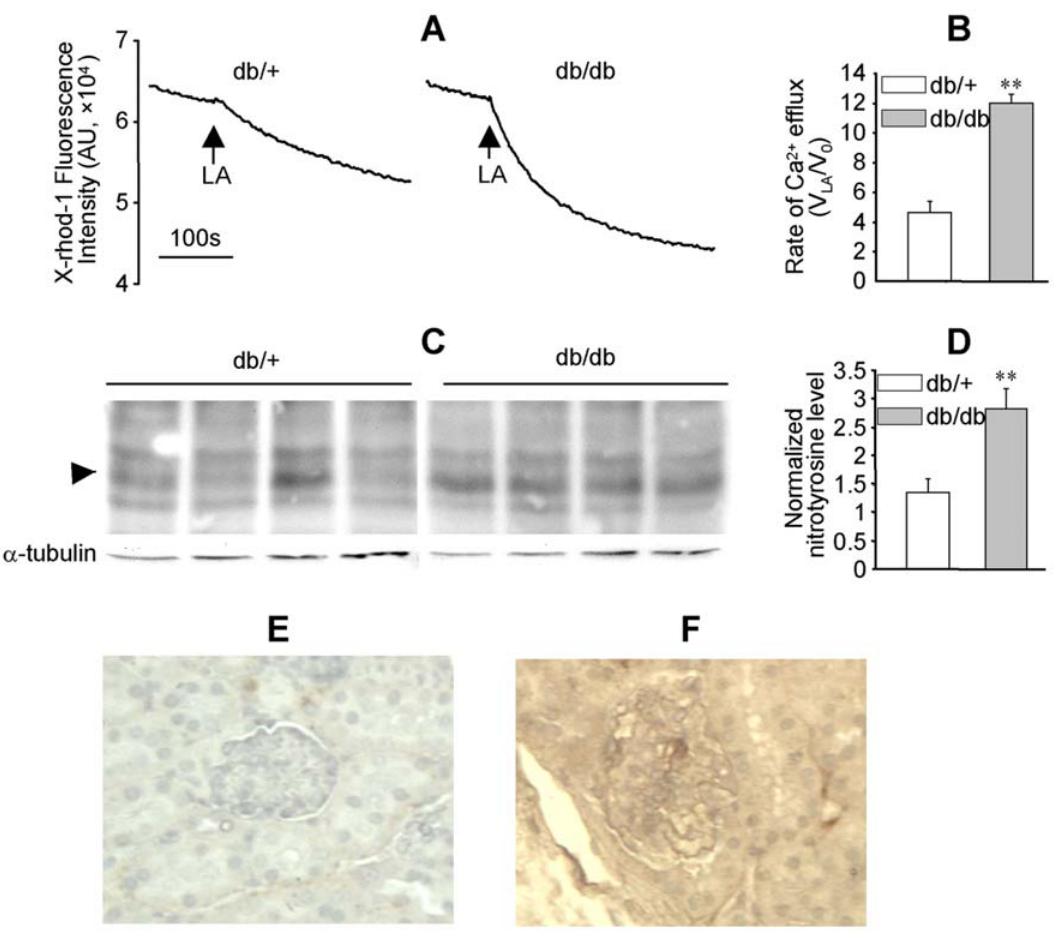
Figure 7. LA-induced mitochondrial Ca 2 + efflux and protein nitrotyrosylation were enhanced in the kidney of db/db mice. Mitochondria were prepared from fresh kidney tissues of 12–16 wk old db/ + and db/db mice and labeled with X-rhod-1 (2 m M). (A): LA-induced mitochondrial Ca 2 + efflux in the kidney of db/ + and db/db mice. (B): The ratio of the initial rate of LA-induced mitochondrial Ca 2 + efflux (V LA ; measured in the first 60 s following LA) to the basal rate (V 0 ; measured prior to LA). The values represent mean 6 SEM of V LA /V 0 , ** P , 0.01, n=3. (C) and (D): Nitrotyrosine levels in the kidney homogenates of four pairs of db/ + and db/db mice were analyzed by western blot using a -tubulin as loading control. The arrowhead highlights a protein band ( , 22 kDa) with enhanced nitrotyrosine levels in db/db mice, ** P , 0.01, n=4. (E) and (F): Representatives of the nitrotyrosine levels in the kidney sections of db/ + and db/db mice as determined by immunohistochemistry.